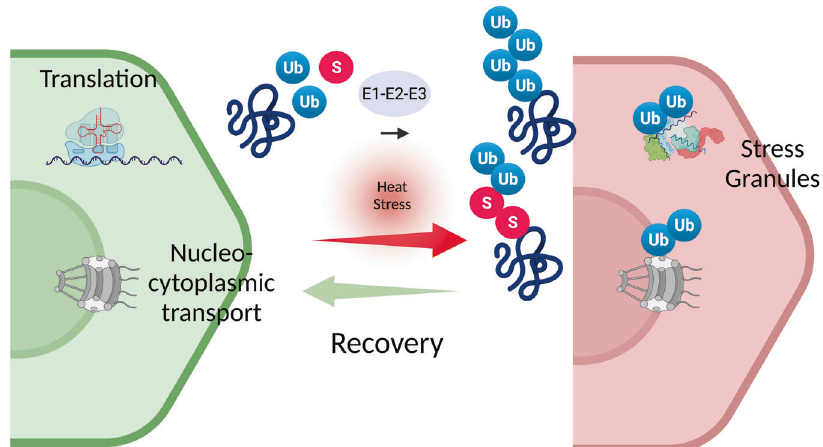
Fig. 1 Heat stress induces polyubiquitylation of SG-associated proteins by an enzymatic E1-E2-E3 cascade. Heat-induced polyubiquitylation prepares cells for the restart of cellular activities upon stress release. The resumption of translation, which is accompanied by the disassembly of SGs is only one critical ubiquitin-regulated process in this recovery phase. Additional processes include the resumption of nucleocytoplasmic transport. The ubiquitin-related SUMO system likely contributes to heat-induced polyubiquitylation of SG-associated proteins (for details see